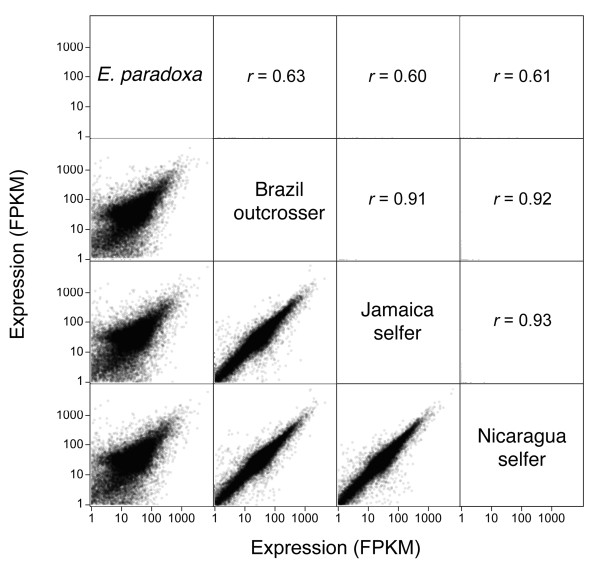
Pairwise correlations of gene expression between the four genotypes: Eichhornia paniculata - Brazil, Jamaica and Nicaragua and Eichhornia paradoxa. Above the diagonal are the correlation coefficients for data plotted below the diagonal. Each pair below the diagonal is expression level plotted on a log scale, measured in FPKM, which estimates gene expression from the number of reads that are derived from each transcript in our samples. All correlations are significant at P < 0.00001.